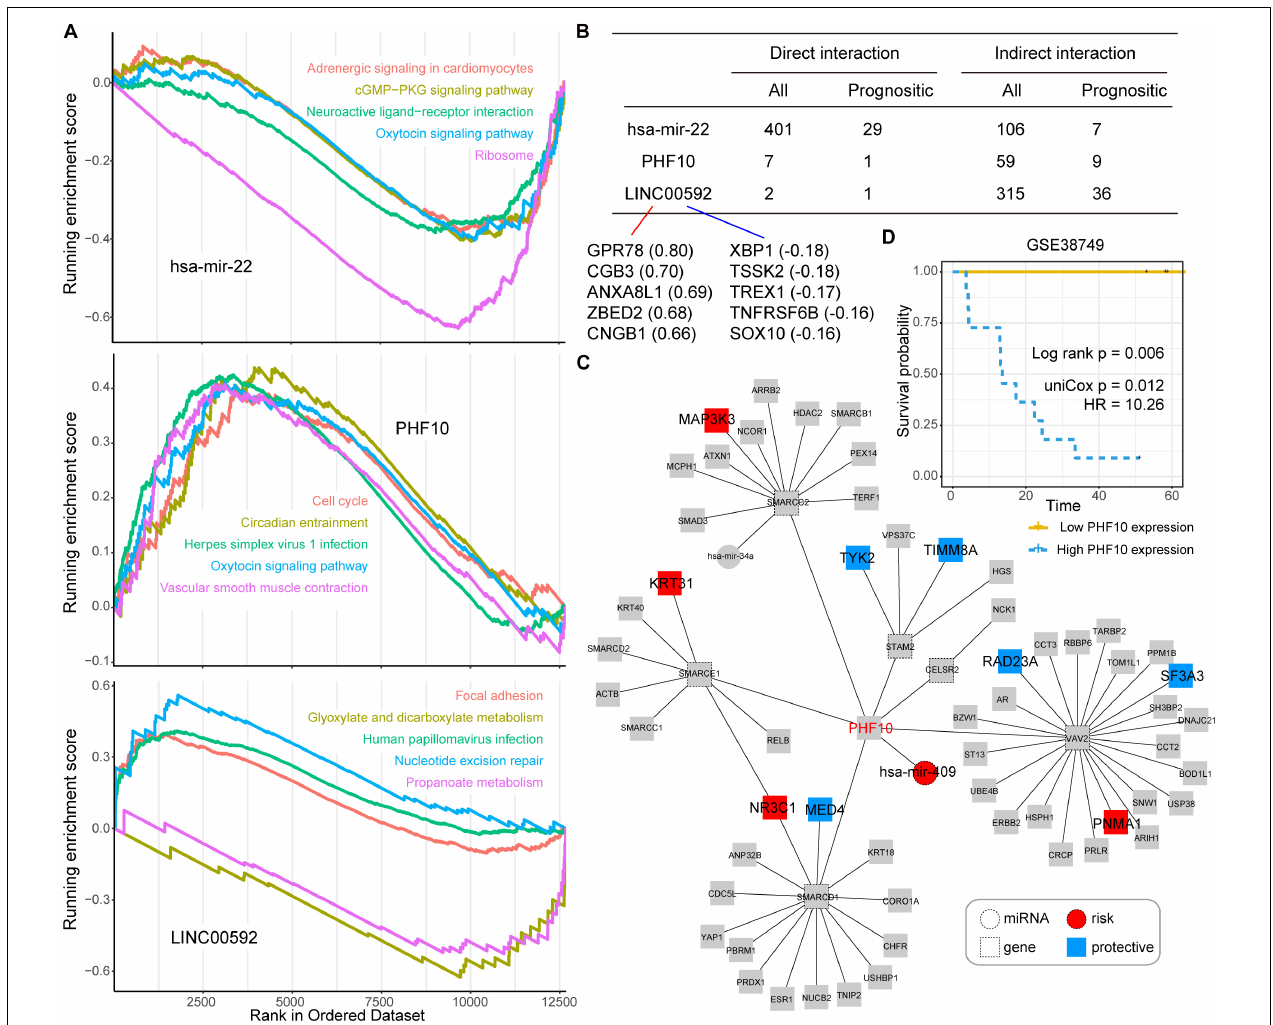
FIGURE 4 | (A) The top five Gene Ontology (GO) terms for three candidate signatures, hsa-mir-22, PHF10, and LINC00592 using the GSEA method. (B ) The prognostic statistic information of direct or indirect interaction of three candidate signatures, hsa-mir-22, PHF10, and LINC00592 within the global network. (C) The PHF10 core network. Red node indicates risk signatures, and blue node indicates protective signatures. (D) The K-M plot of PHF10 expression in GSE38749 and median expression level of PHF10 was the cut-off to define two groups, and the log-rank test was used to calculate the P